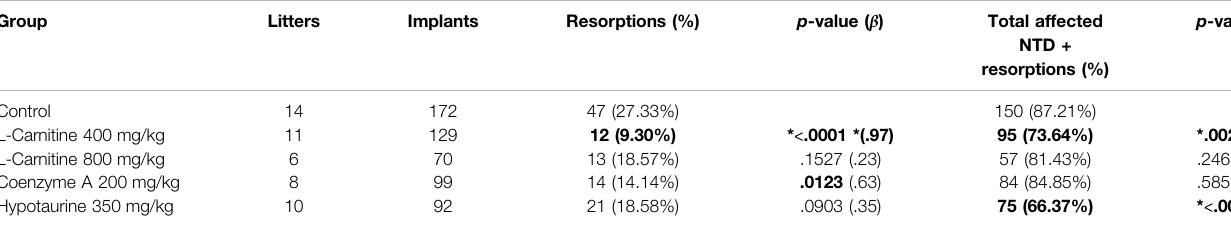
p-values less than .05 and β values greater than .80 are highlighted with bold